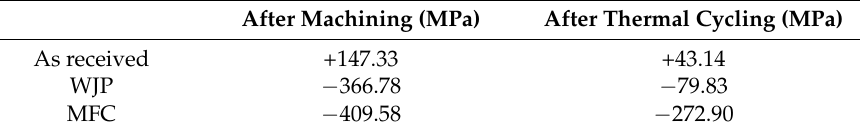
Table 2. Residual stress in specimens after thermal cycling.